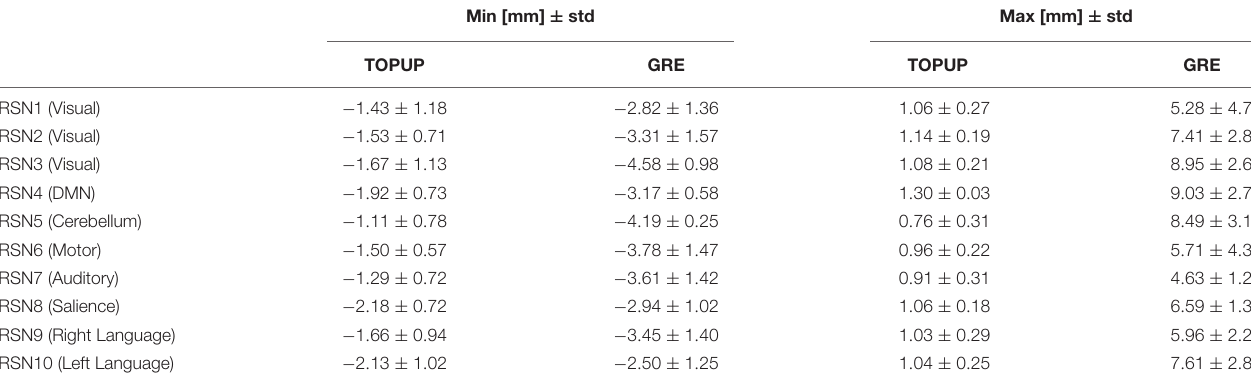
TABLE 6 | Range of voxel shifts, averaged across runs, within each RSN, from the participant-averaged VSMs in the MNI space estimated by TOPUP and GRE. Min [mm] ± std Max [mm] ± std